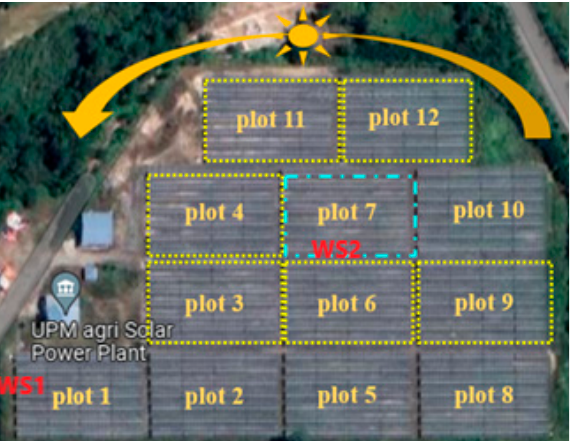
Figure 5. Google map layout of LSS PV farm in Puchong, Selangor ( fi ve acres). WS is the location for Weather Station.